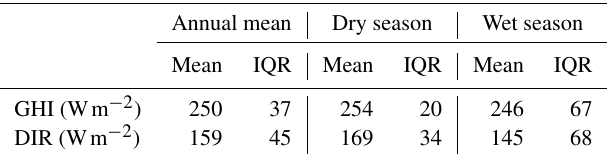
Table 4. Regional mean and regional interquartile range (IQR) of the temporal mean GHI and DIR between 1983 and 2017 for the annual mean, the dry season and the wet